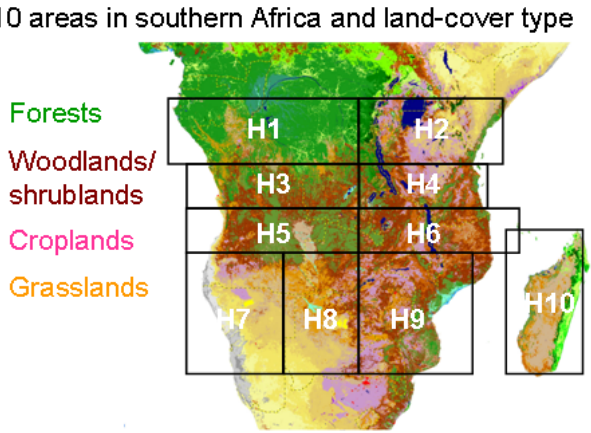
Figure 5. Definition of the studied areas in Africa, adapted from Hoelzemann (2006). Vegetation map is from Mayaux et al. (2003). Table 1. Coordinates of the studied areas in southern Africa, corre- sponding to Fig.